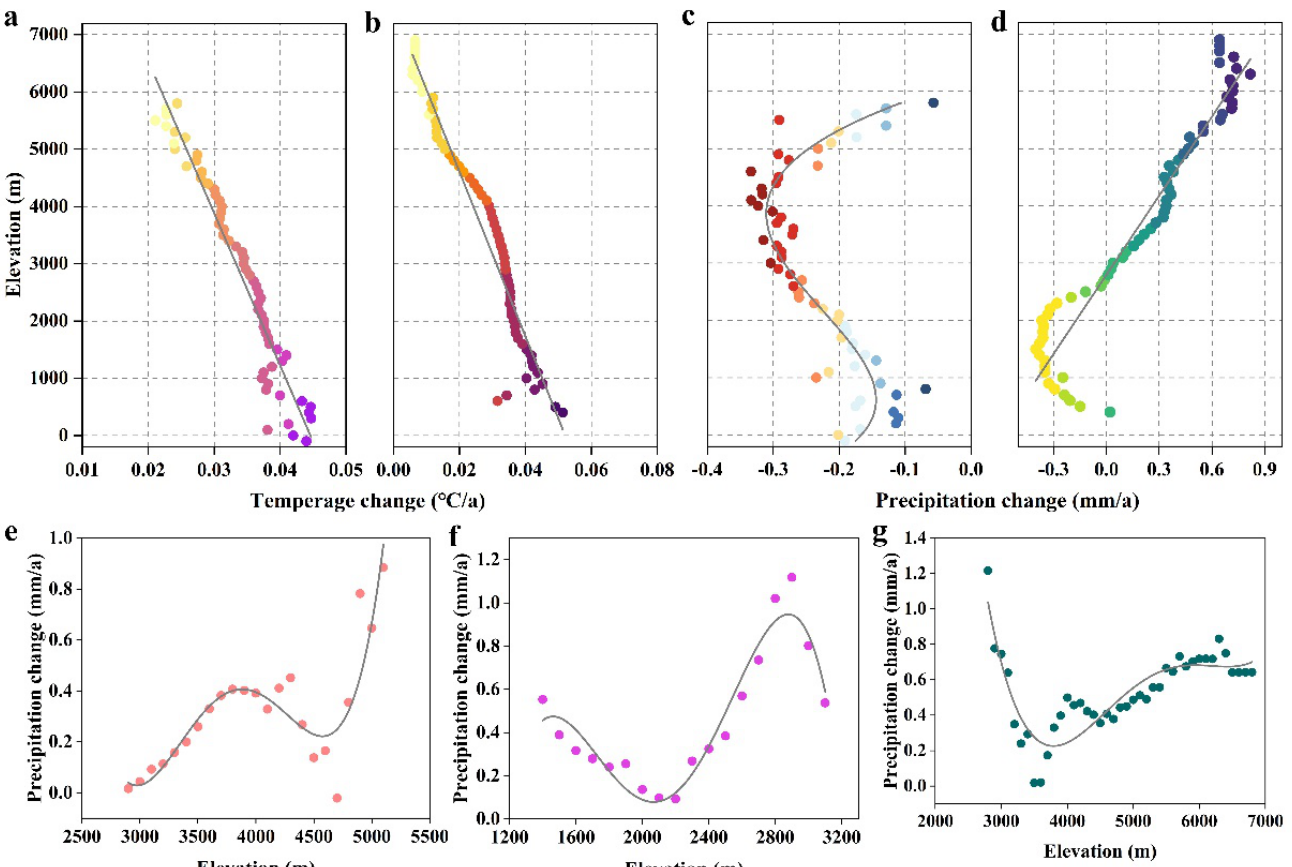
Figure 3. Climatic trends along an altitudinal gradient and main vegetation belts. ( a , b ): temperature trends of the Desert Ecozone and Tianshan Mountains Ecozone at different altitudes, respectively. ( c , d ): precipitation trends of the Desert Ecozone and Tianshan Mountains Ecozone at different altitudes, respectively. ( e – g ): wetting trends of three vegetation belts in the Tianshan Mountains Ecozone (alpine meadow, coniferous forest, and nival belts, respectively) at different altitudes.